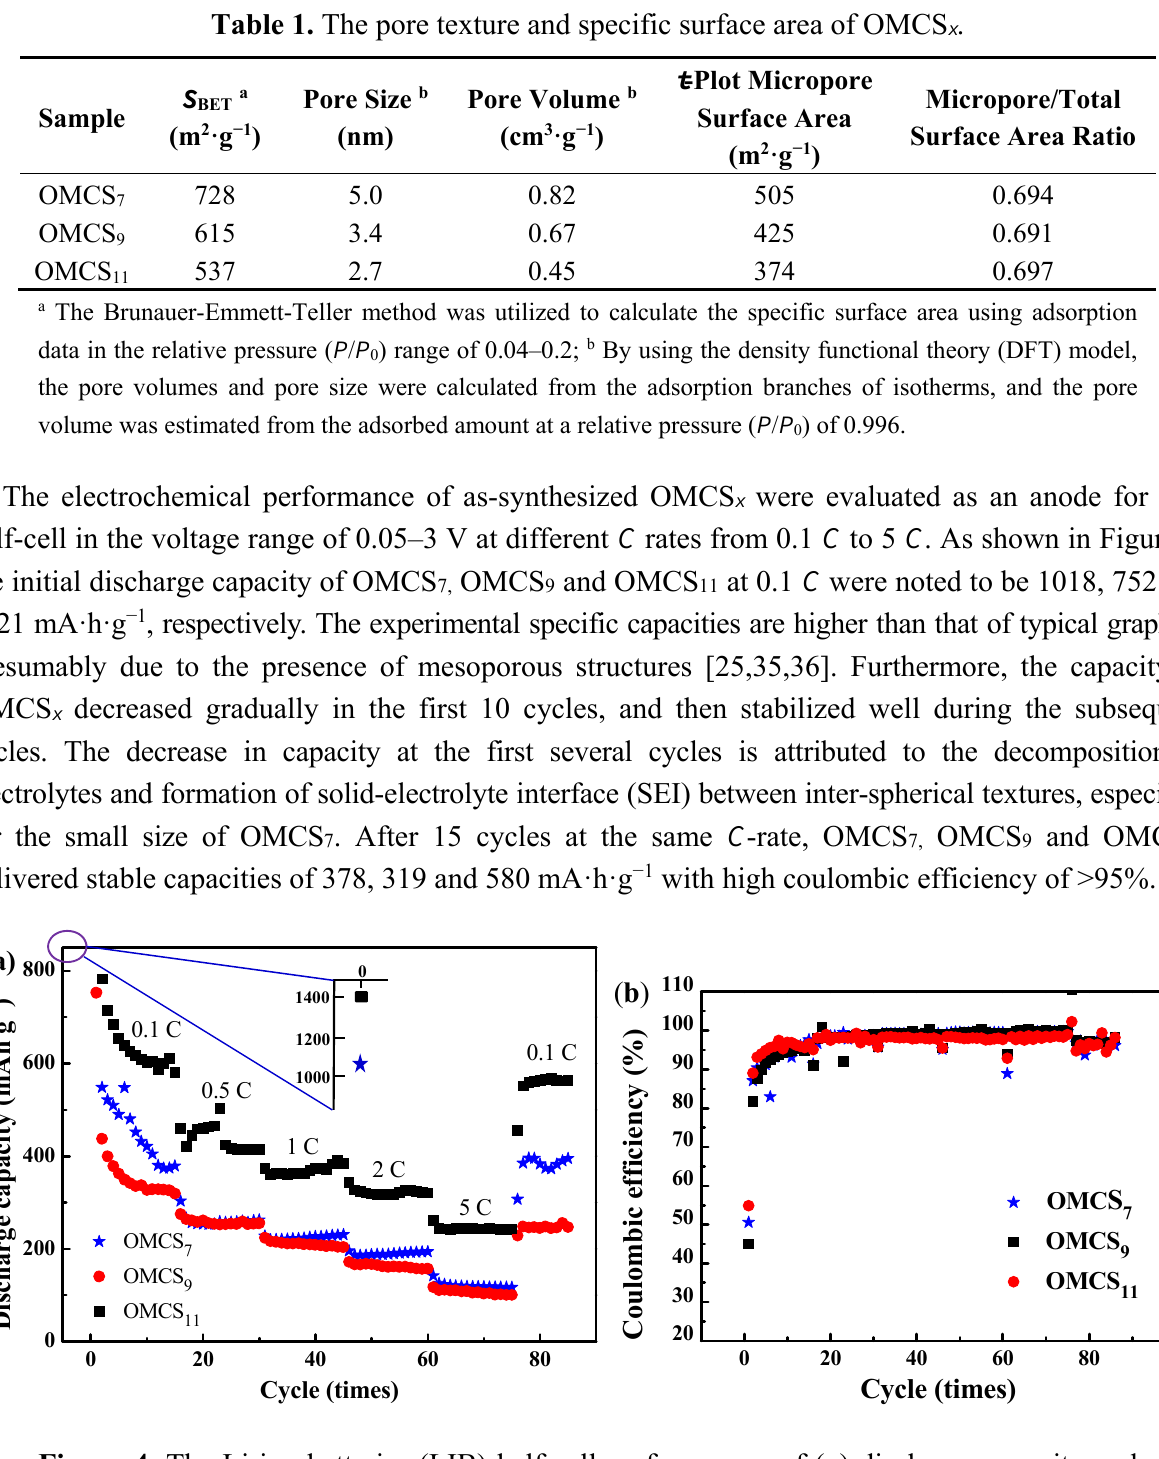
Figure 4. The Li-ion batteries (LIB) half cell performances of ( a ) discharge capacity and ( b ) coulombic efficiency of OMCS x under various C rates from 0.1 C to 5 C